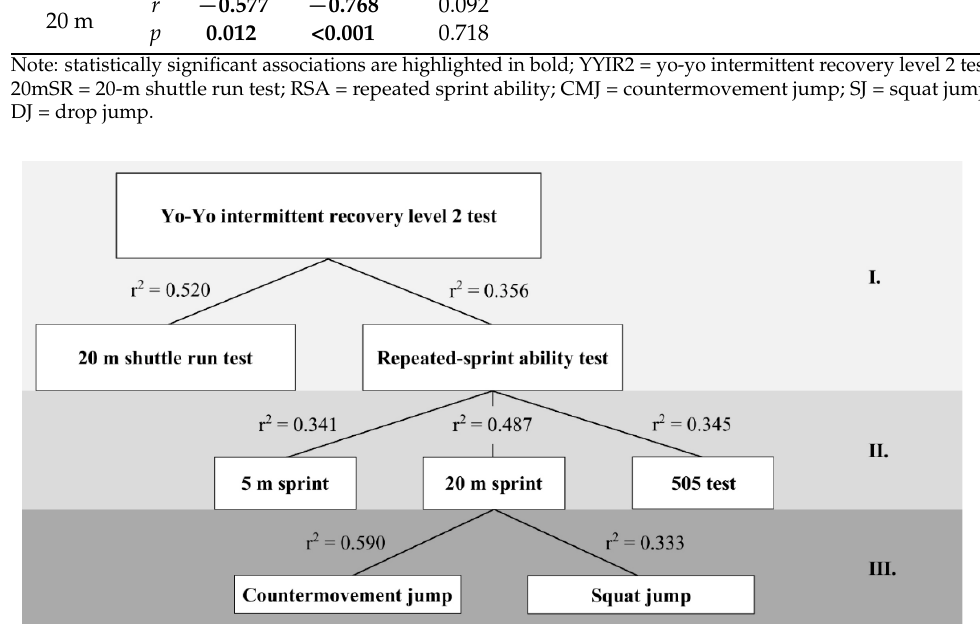
Figure 2. The three-level model of factors contributing to yo-yo intermittent recovery level 2 test performance. Note: r 2 = coefficient of determination .